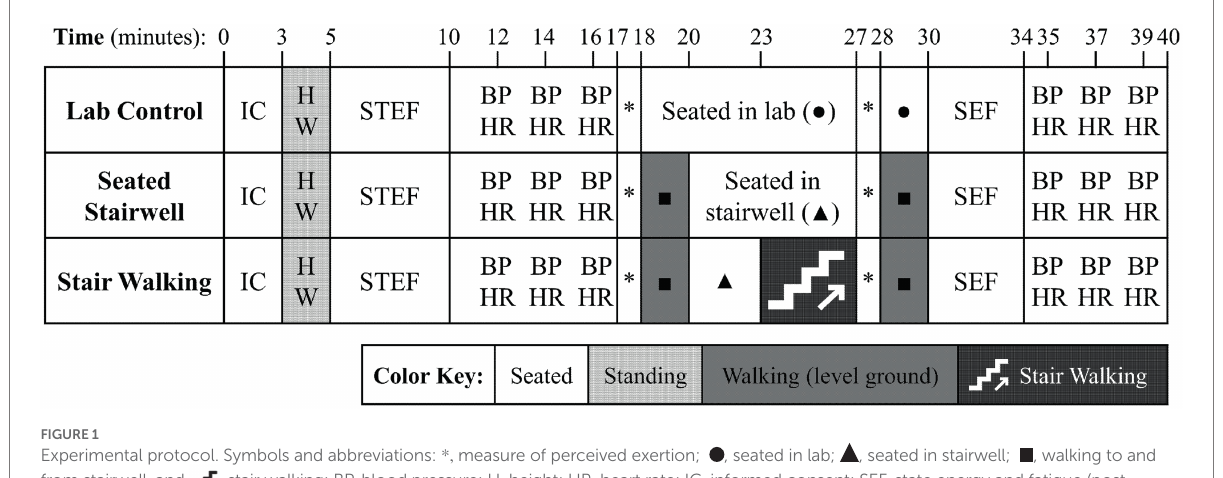
FIGURE 1 Experimental protocol. Symbols and abbreviations: *, measure of perceived exertion; , seated in lab; , seated in stairwell; , walking to and from stairwell,